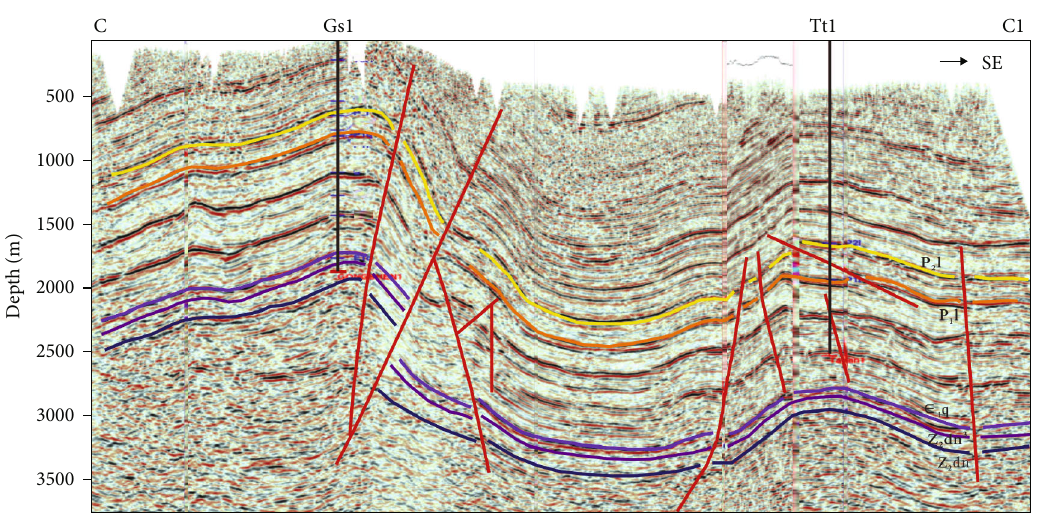
Figure 4: Seismic pro fi le of the Tiangongtang-Datachang tectonic system in southwestern Sichuan Basin.